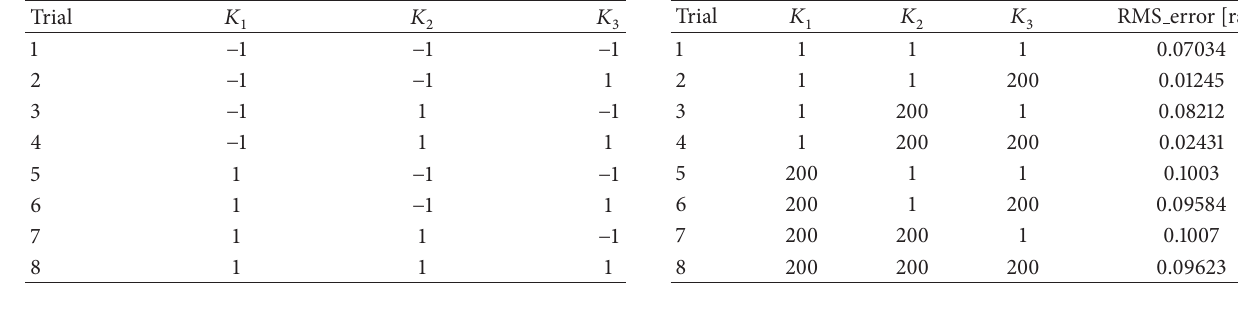
Table 1: The design space of the experiment. Table 2: The work space of the experiment.